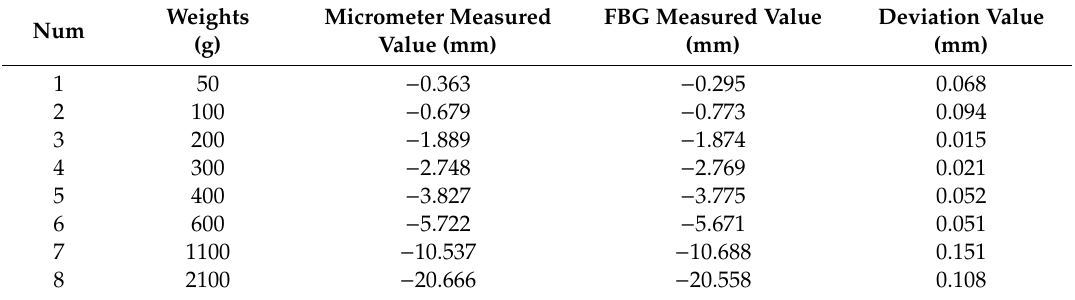
Table 2. Measurement value of FBG